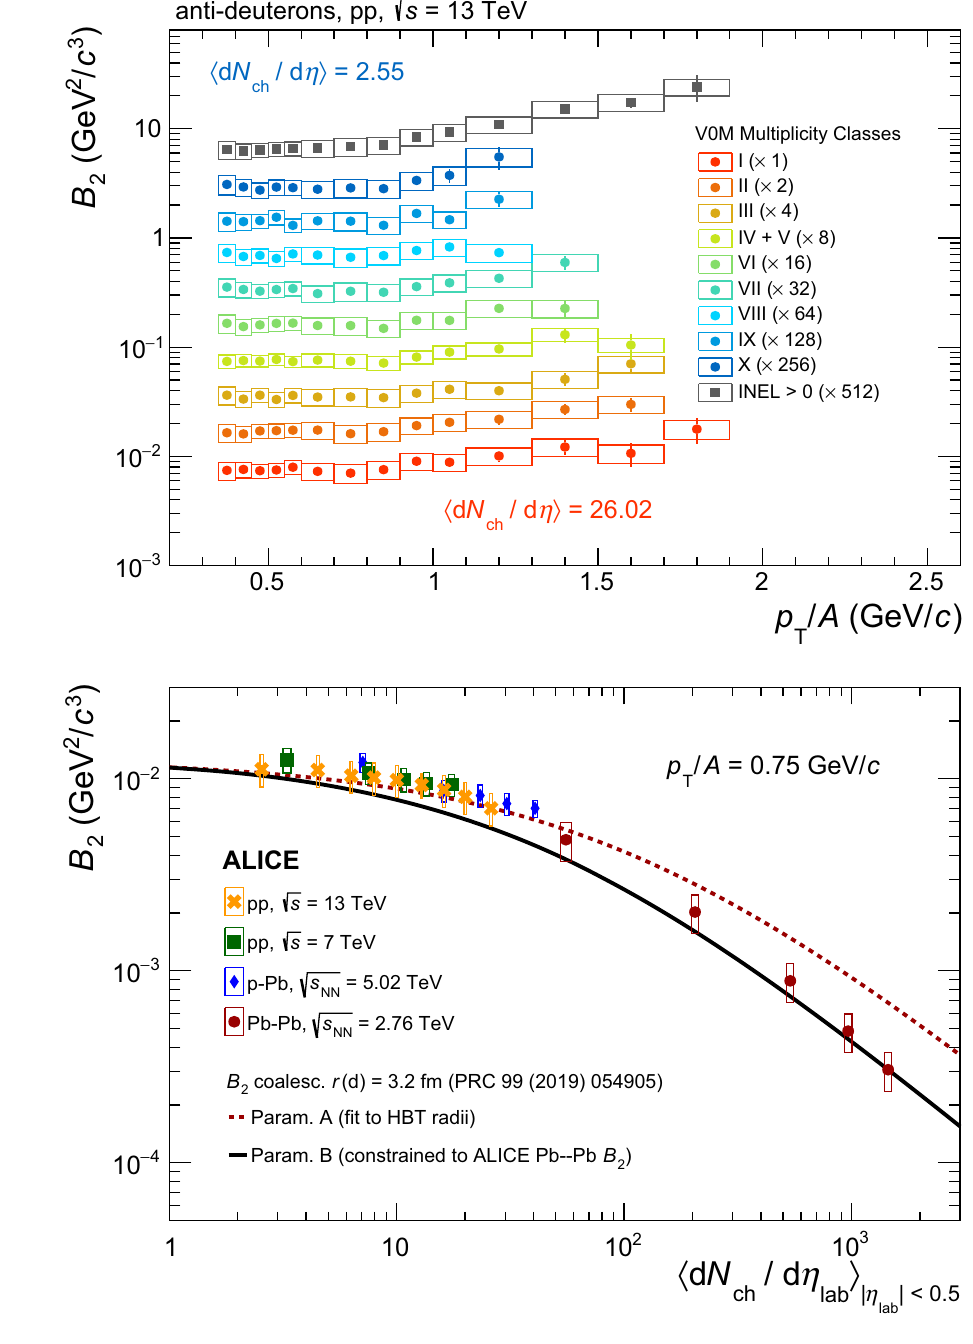
in terms of rapidity units d V / d y , corresponding to one and three units of rapidity, respectively. The model